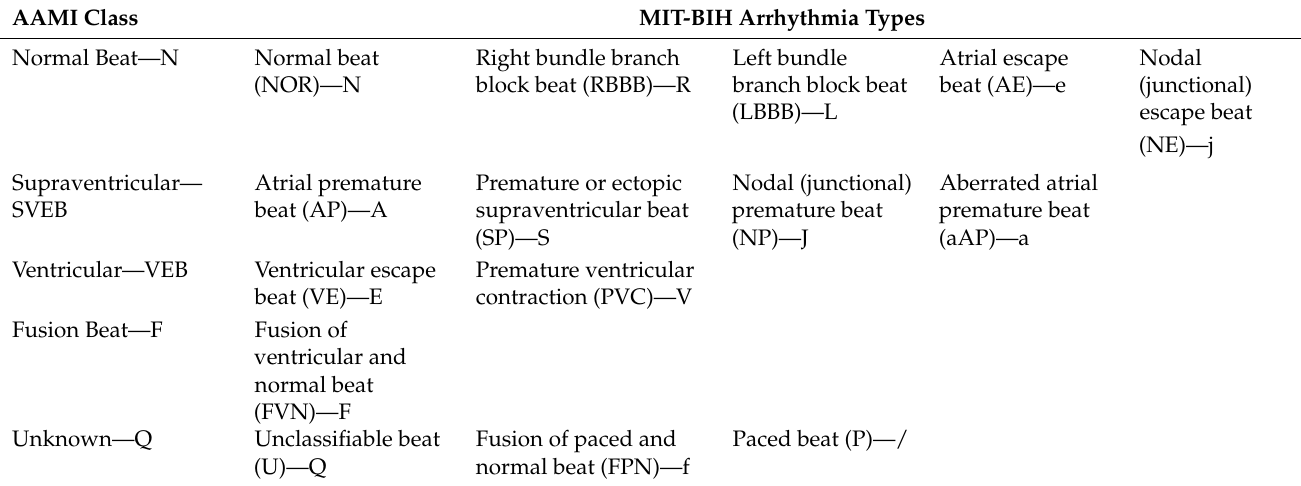
Table 1. Mapping of the MIT-BIH arrhythmia types and AAMI